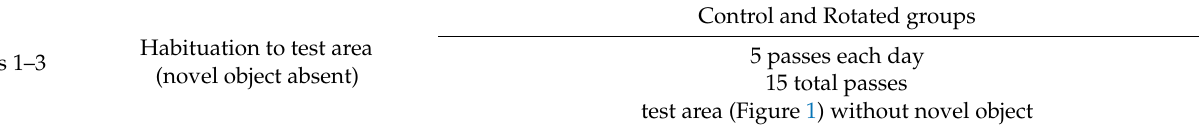
Table 1. Testing Procedure: Outline of testing procedure to provide details of the Control and Ro- tated group procedures.